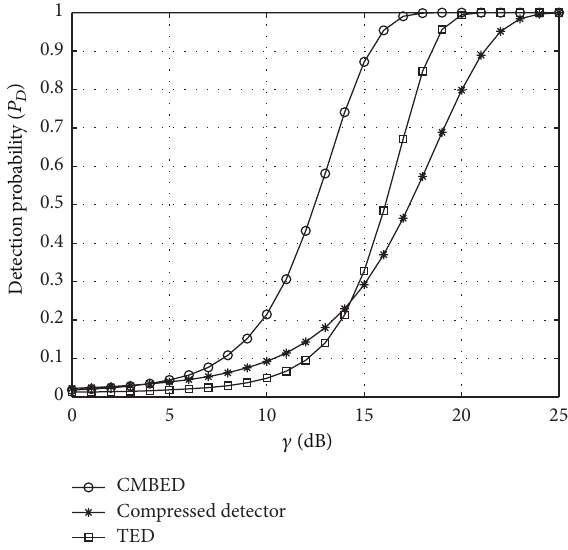
Figure 6: Probability of detection versus SNR when 𝑃 𝐹 = 0.01 and a compression ratio of